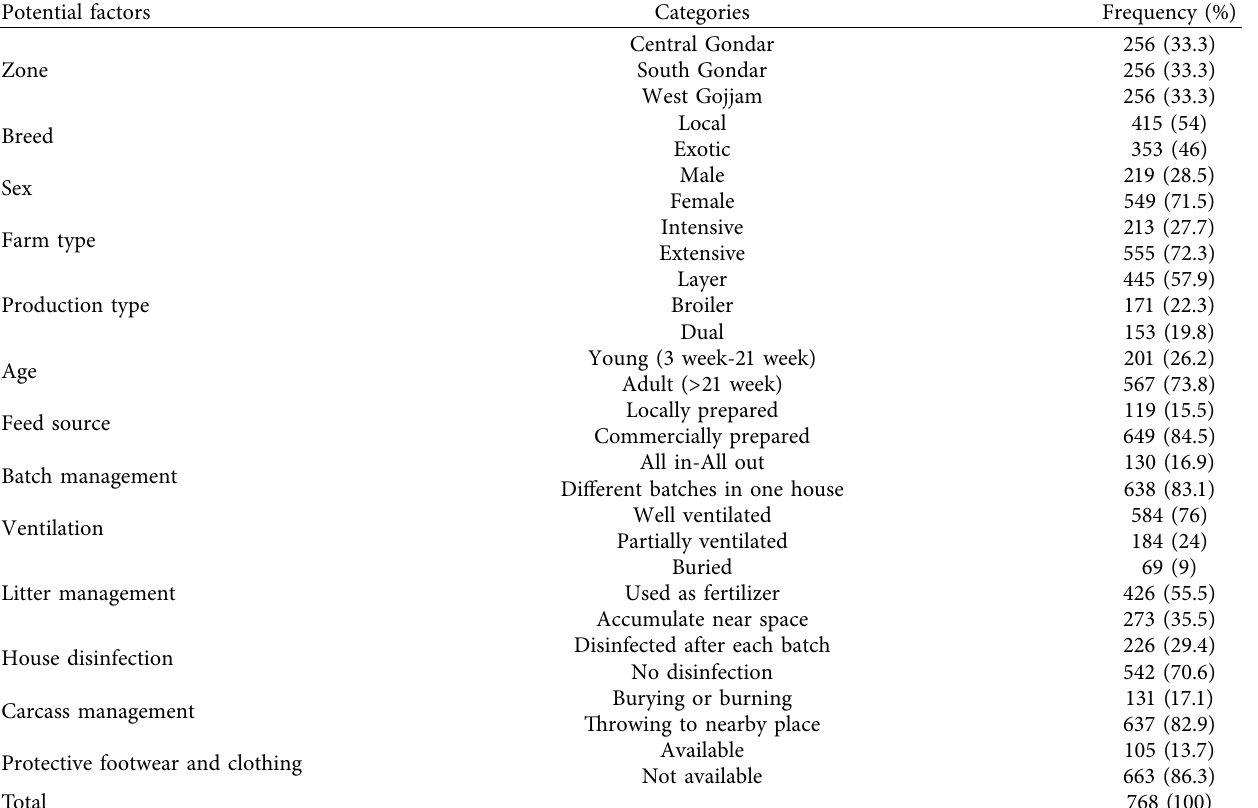
Table 1: Summary of potential risk factors and their respective